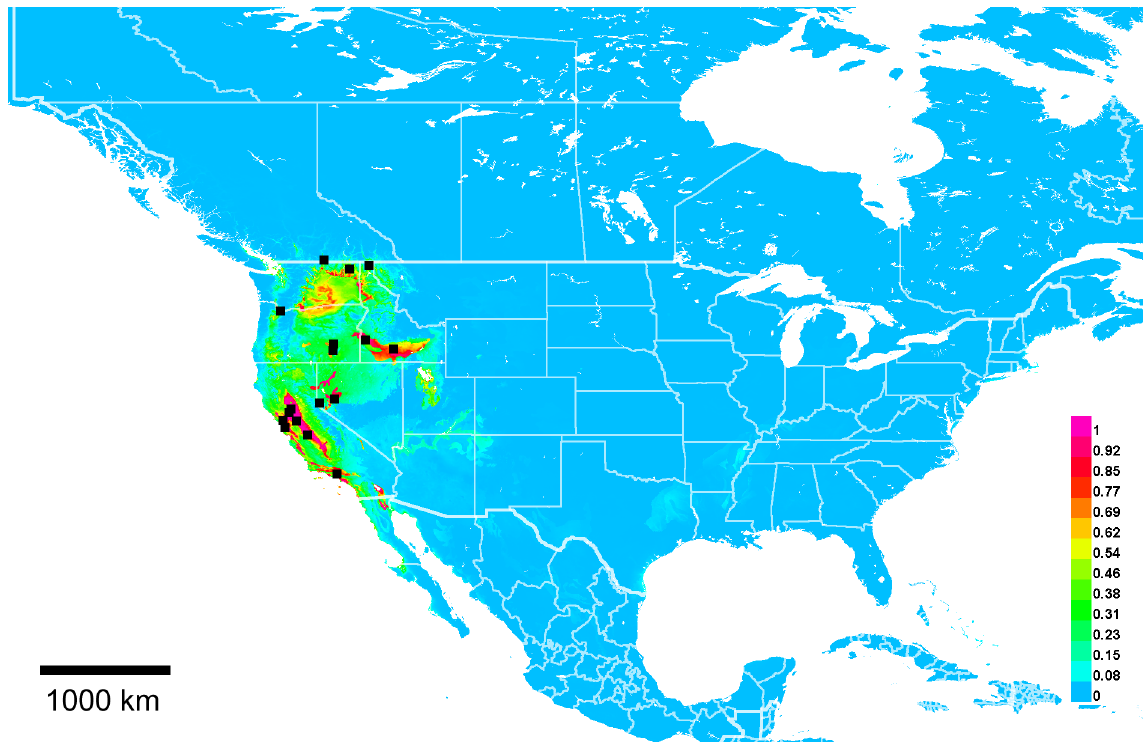
Fig. 75. Georeferenced collection records of Lasioglossum ( D .) tegulariforme (Crawford, 1907) (black squares) and predicted distribution by maximum entropy ecological niche modelling in Maxent (colour shading). Warmer colours indicate higher cloglog probability of